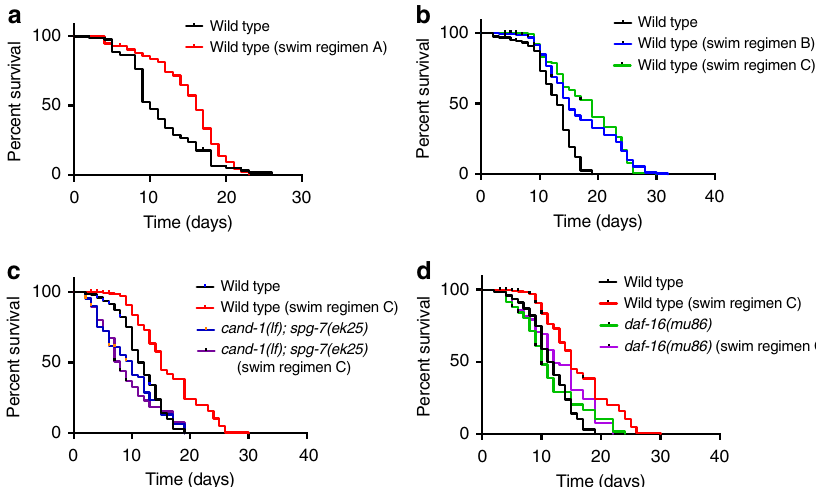
Fig. 7 Exercise extends lifespan that is dependent on the mitochondrial fusion pathway. a – d Survival curves for adults that were kept continuously on agar plates or removed from the plates for brief periods for the described swim regimens. a Comparison of wild-type kept on agar plates continuously or subject to swim regimen A (30 min of swimming per day). b Test of swim regimens B and C. Swim regimen B was the following swimming times per day on the listed days: 30 min on days 1 – 5; 25 min on days 6 and 7; 20 min on days 8 and 9; 15 min on day 10; 10 min on day 11; and 5 min on day 12. Swim regimen C was 30 min of swimming on day 1, followed by a reduction in swim time of 2 min per day on subsequent days. c , d Test of swim regimen C with wild type, cand-1(tm1683) ; spg-7(ek25) c , or daf-16(mu86) d . The wild-type control and wild-type swim regimen C survival curves were analyzed at the same time and are shown in c , d for comparison. All swimming regimens signi fi cantly increased the mean lifespan of wild type a – d . Swim regimen C did not increase the mean lifespan of cand-1(tm1683); spg-7(ek25) c or daf-16(mu86) mutants d relative to the control, non-swimming condition. All lifespan experiments were performed with four biological replicates. See Supplementary Table 3 for